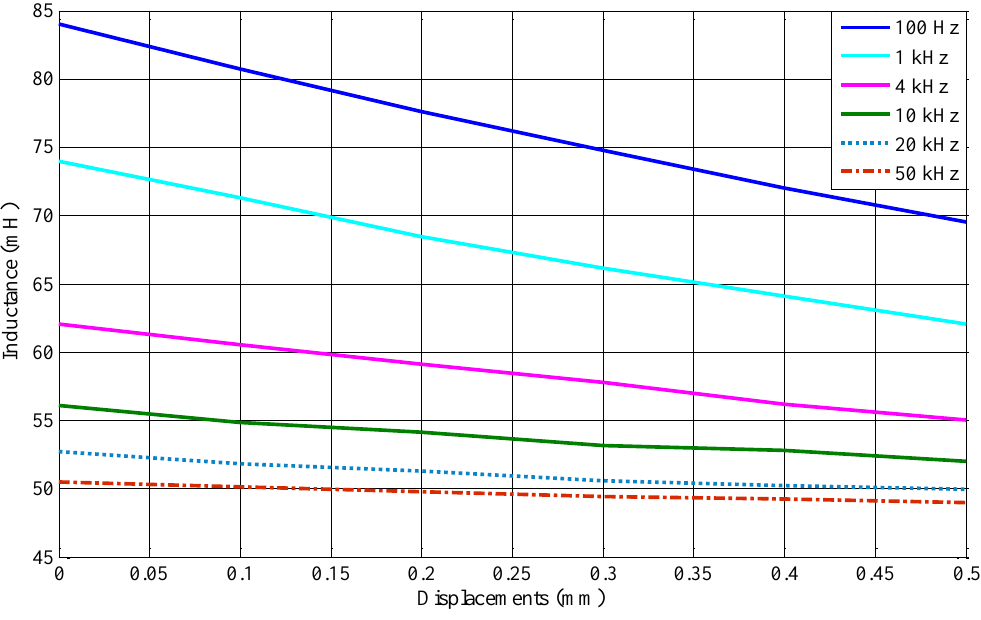
Figure 6. Characteristic of the inductance versus the displacement.